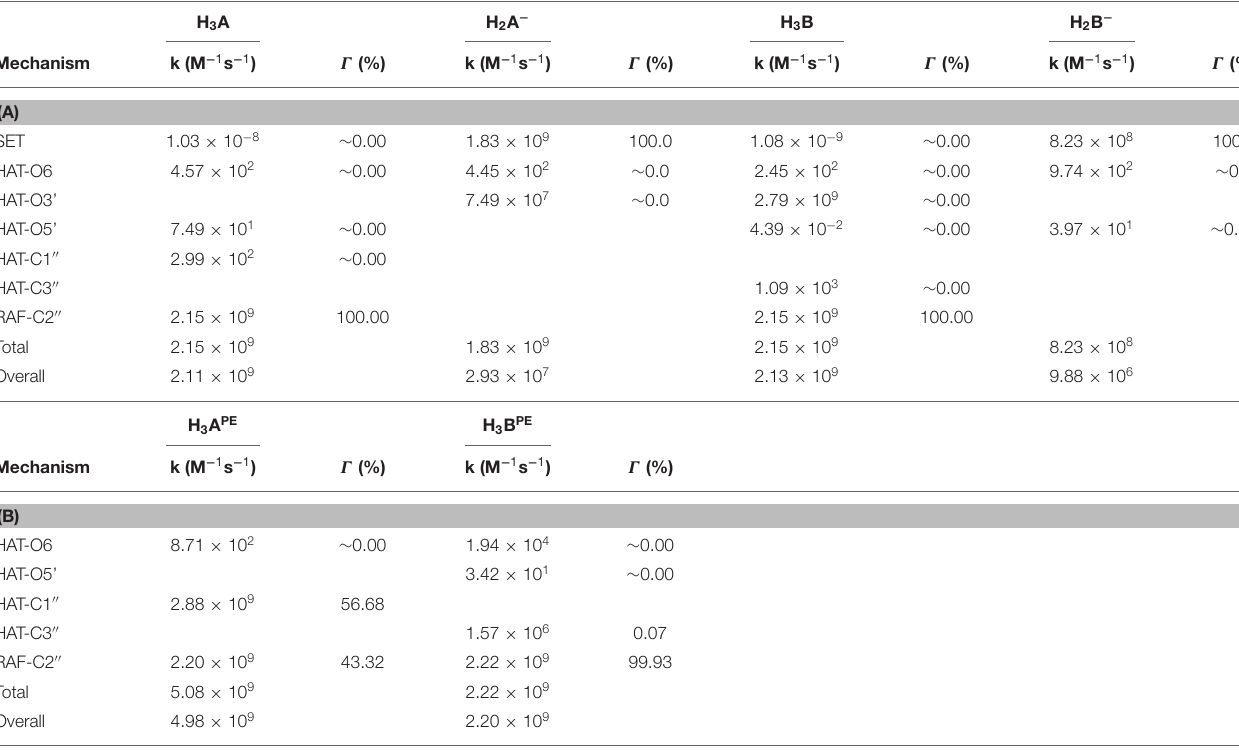
TABLE 4 | Rate constants (M − 1 s − 1 ) and branching ratios ( Γ ) computed at the M05-2x level of theory at 298.15 K, (A) in aqueous and (B) in pentyl ethanoate solvent. H 3 A H 2 A − H 3 B H 2 B −